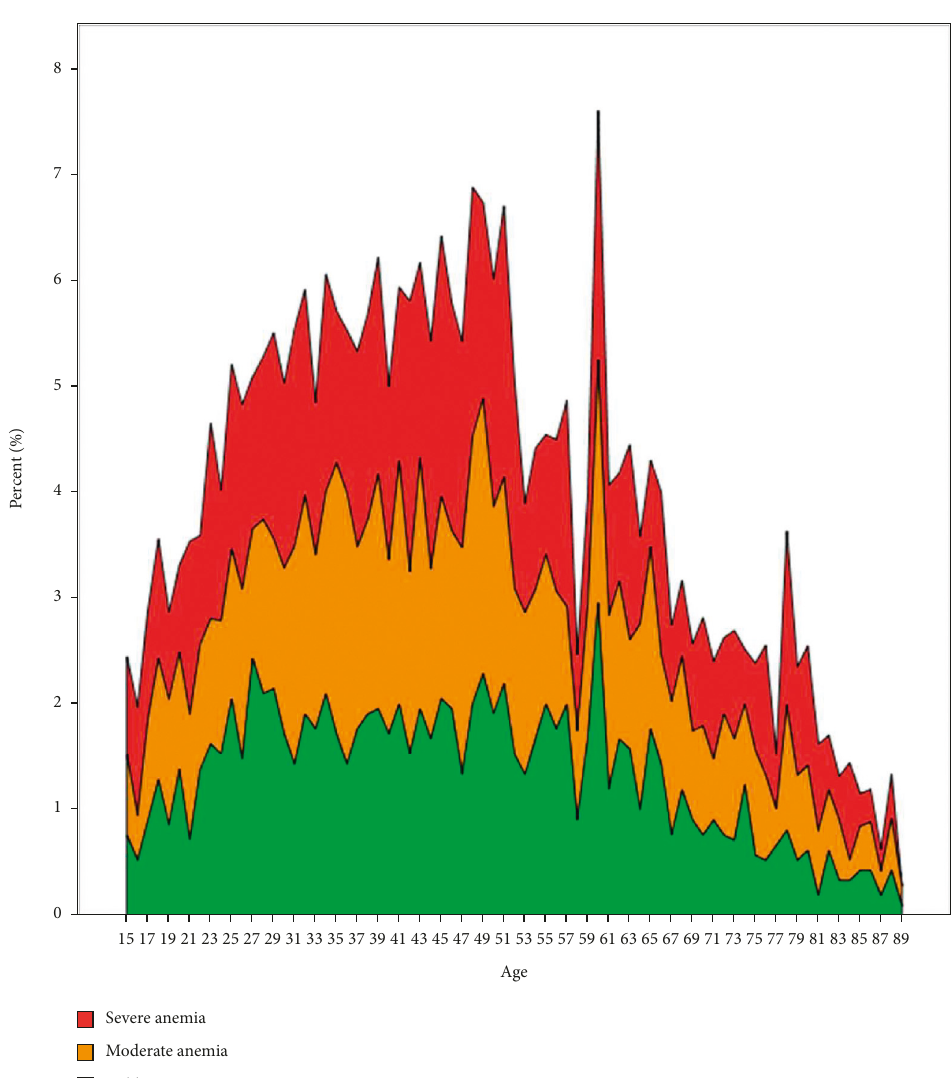
Figure 5: Age-wise prevalence of mild, moderate, and severe anemia in